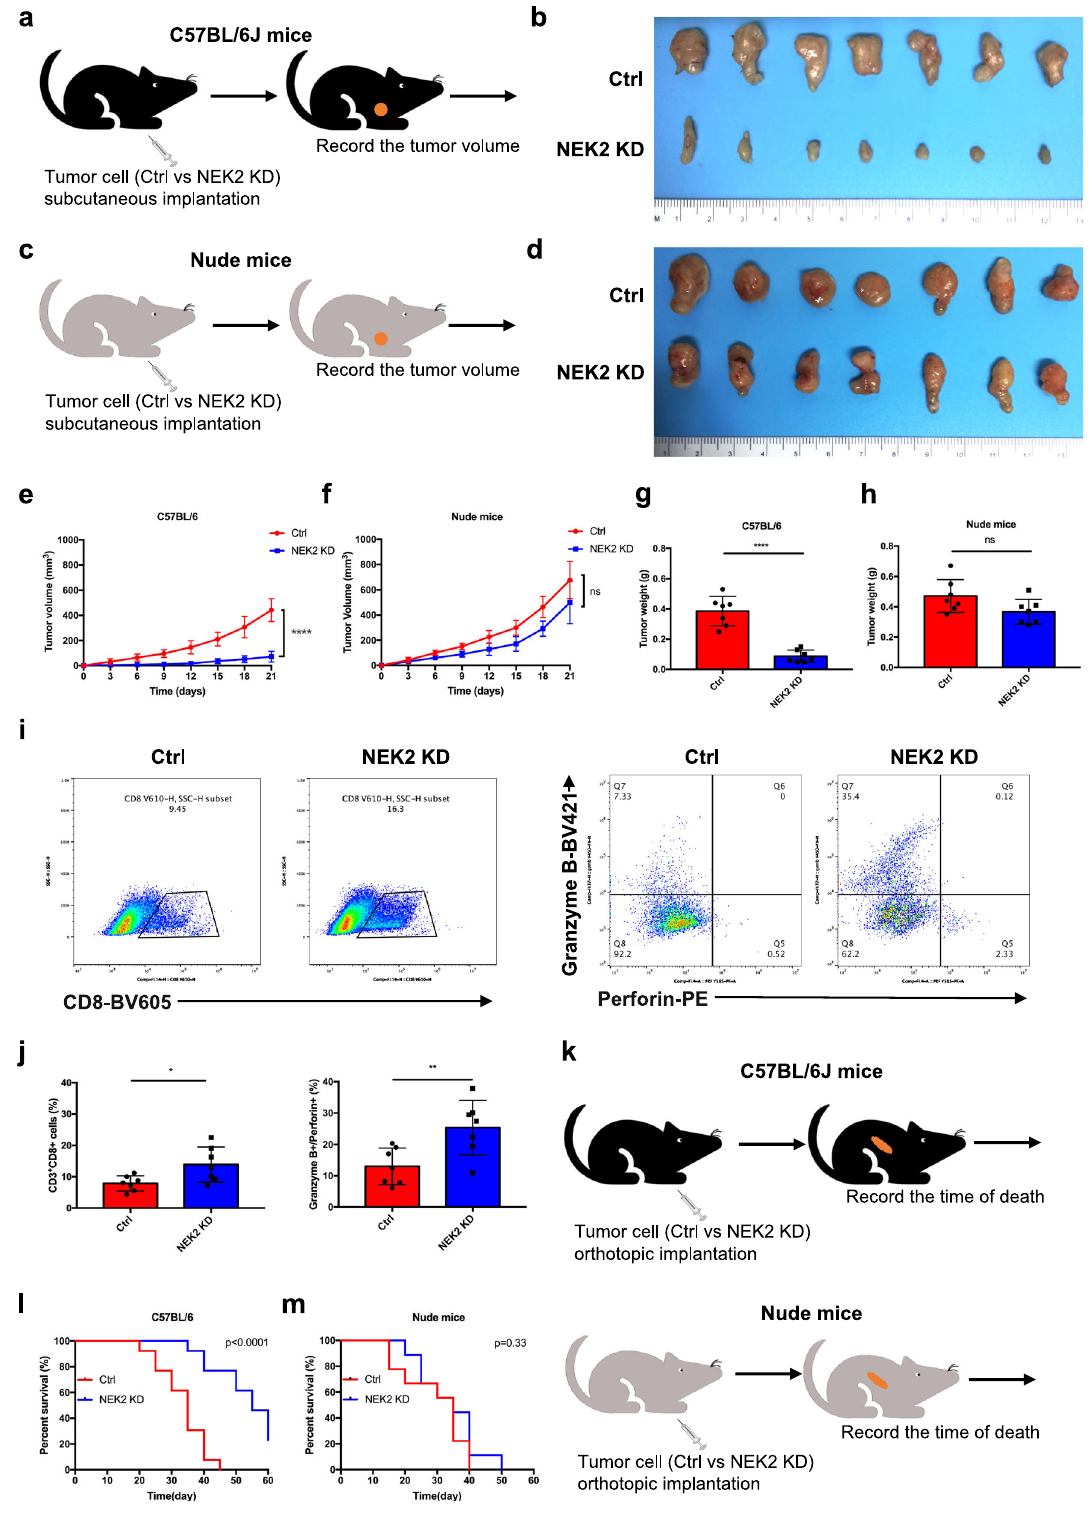
NEK2 inhibits ubiquitination-mediated proteasomal degrada- tion of PD-L1 . To further investigate the manner in which NEK2 regulates PD-L1, we measured the expression levels of PD-L1 in NEK2 inhibitor-treated, NEK2 KD, or overexpressed cells. NEK2 inhibition or depletion decreased PD-L1 expression in